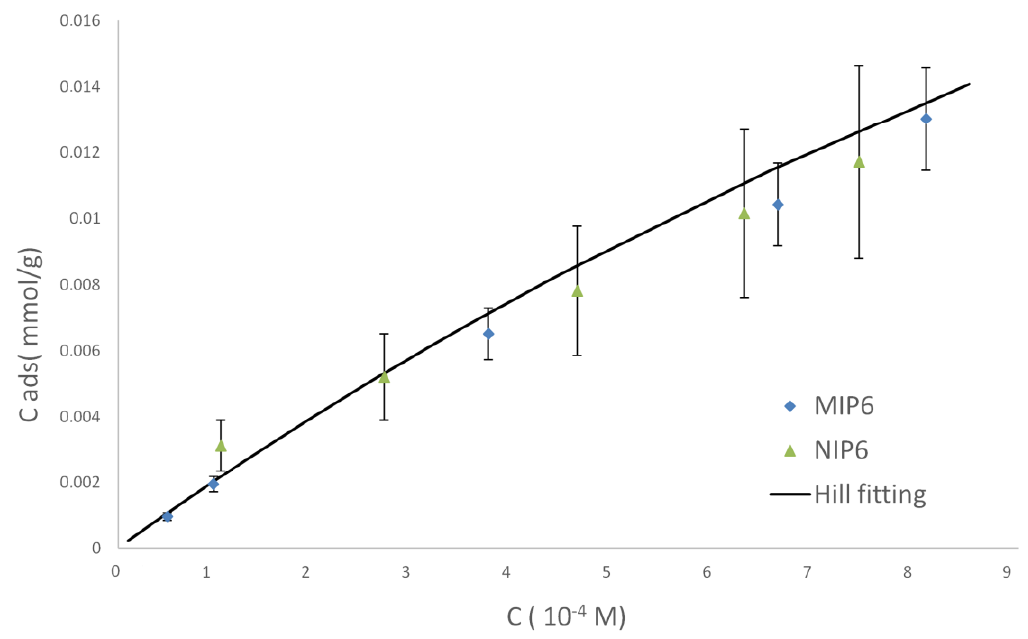
Figure 1. Binding isotherms of 2-FAL on MIP and NIP from water, at 75 mL sol /g MIP .